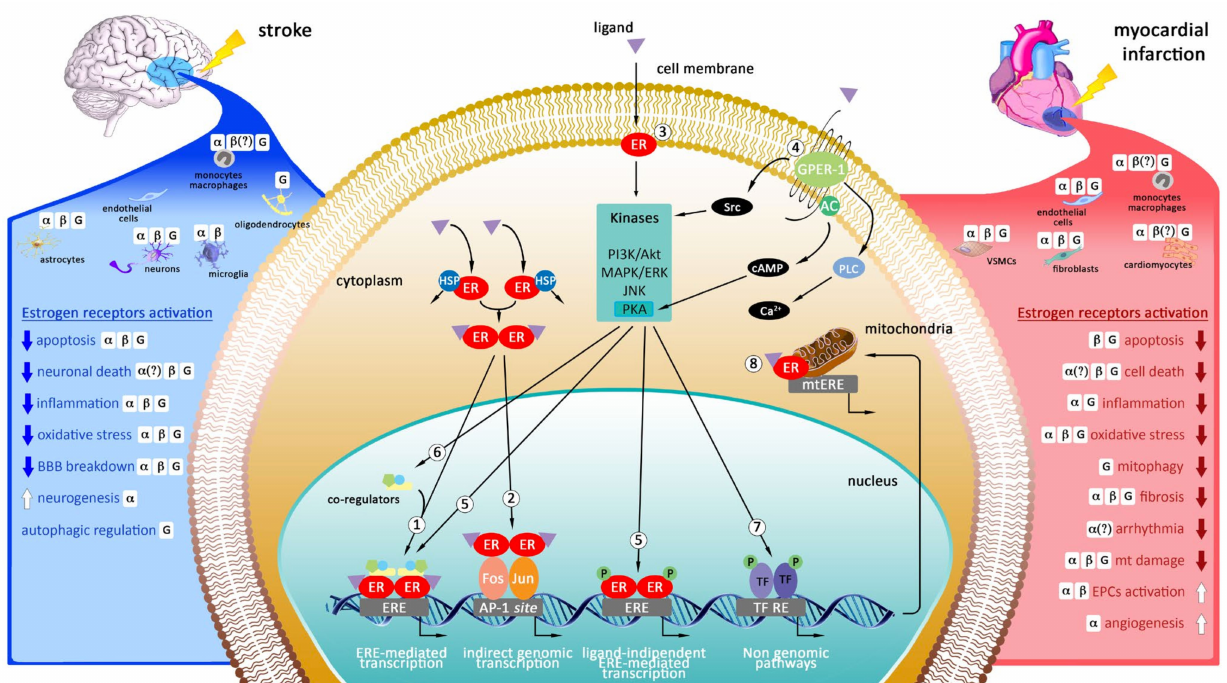
Figure 1. Schematic model representing the cellular localization, the molecular mechanisms and the effects of estrogen receptors activation after cerebral and cardiac ischemia. Genomic pathway: estrogen agonist directly induces dimerization of ERs and translocation to the nucleus. The complex ligands-ERs can (1) bind the estrogen-response-element (ERE) of gene promoters and induce target gene transcription, or (2) interacts with other transcription factors (TF) (e.g., Fos and Jun). Non-genomic pathway: estrogen agonist binds cell membrane ERs (3) or GPER-1 (4) triggering rapid cytosolic phosphorylation cascades through membrane-associated proteins. These kinases can phosphorylate and activate either ERs (5), both in a ligand-dependent and in a ligand-independent manner, or its associated co-regulators (6), enhancing or inhibiting the genomic action of ERs. Activated kinases can also affect gene transcription through phosphorylation of several TFs (7). In addition, estrogen-agonist activates ERs located in mitochondria, regulating mitochondrial function